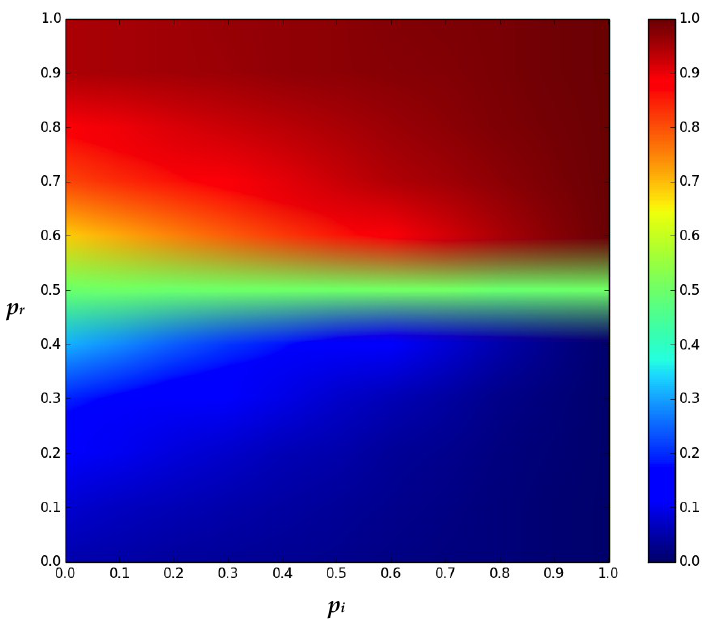
Figure 2. Strategy distribution in the proposed model, on varying the degrees of freedom p i and p r , i.e., the imitation probability and the probability a rational agent succeeds over an irrational one, respectively. Red indicates full rational, while blue full irrational. Results have been averaged over 100 simulation